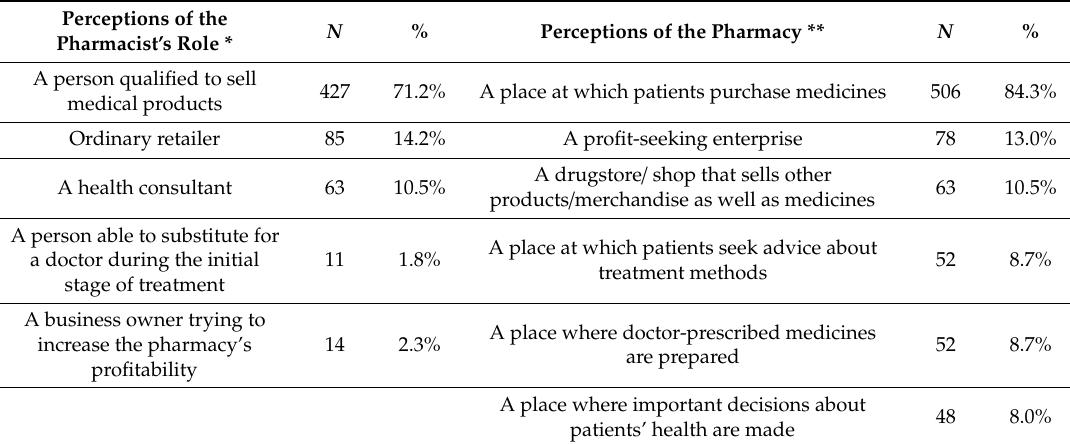
Table 3. Respondents’ opinions of pharmacists and